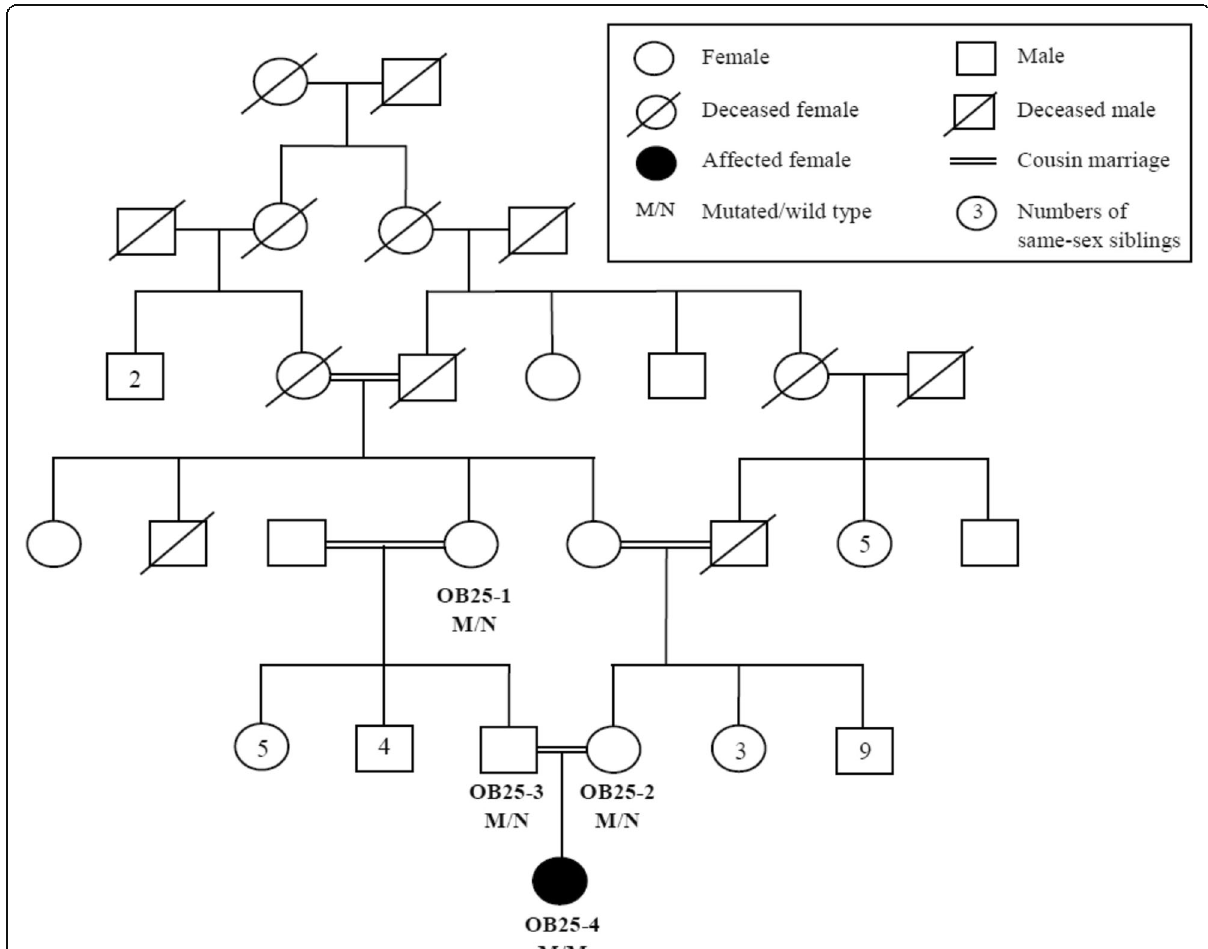
Fig. 2 Pedigree of family OB25 with the missense mutation c.2675C> G (p.Pro892Arg) in